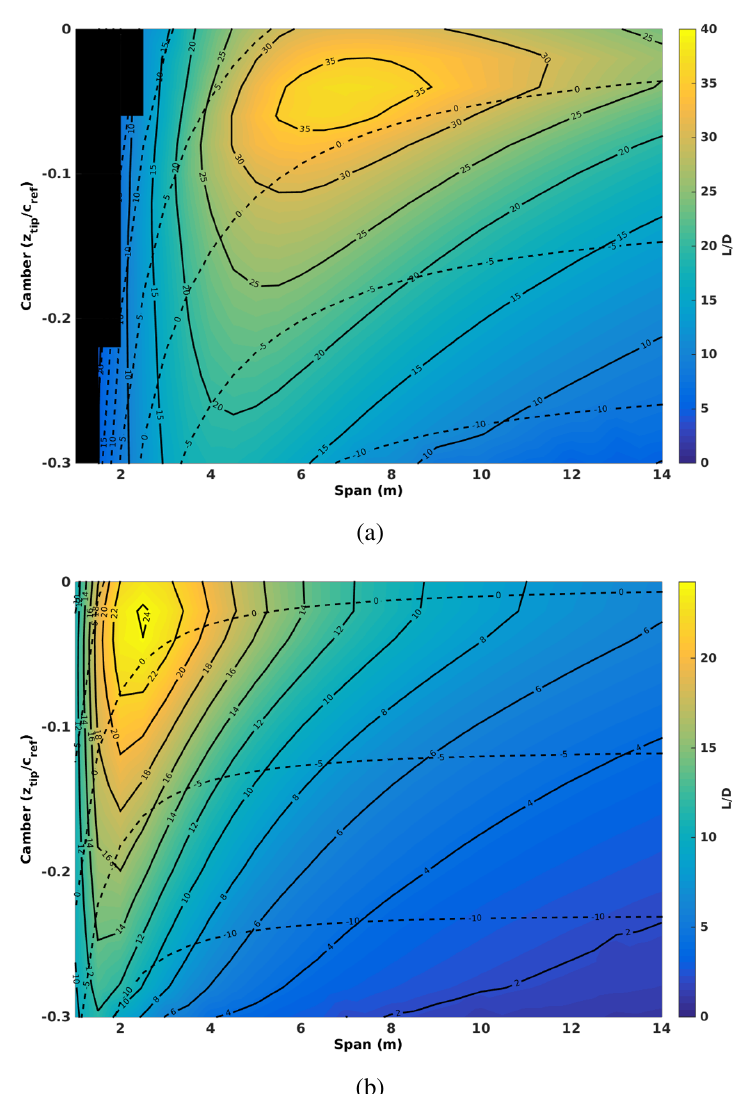
Figure 7. Nominal parameter sweeps for camber and span for the minimum and maximum speed flight conditions, where the colour map and solid contours represent aerodynamic efficiency and the dashed contours represent the required angle of incidence to trim the lift of the wing. ( a ) Parameter sweep at 50 kph; ( b ) parameter sweep at 115